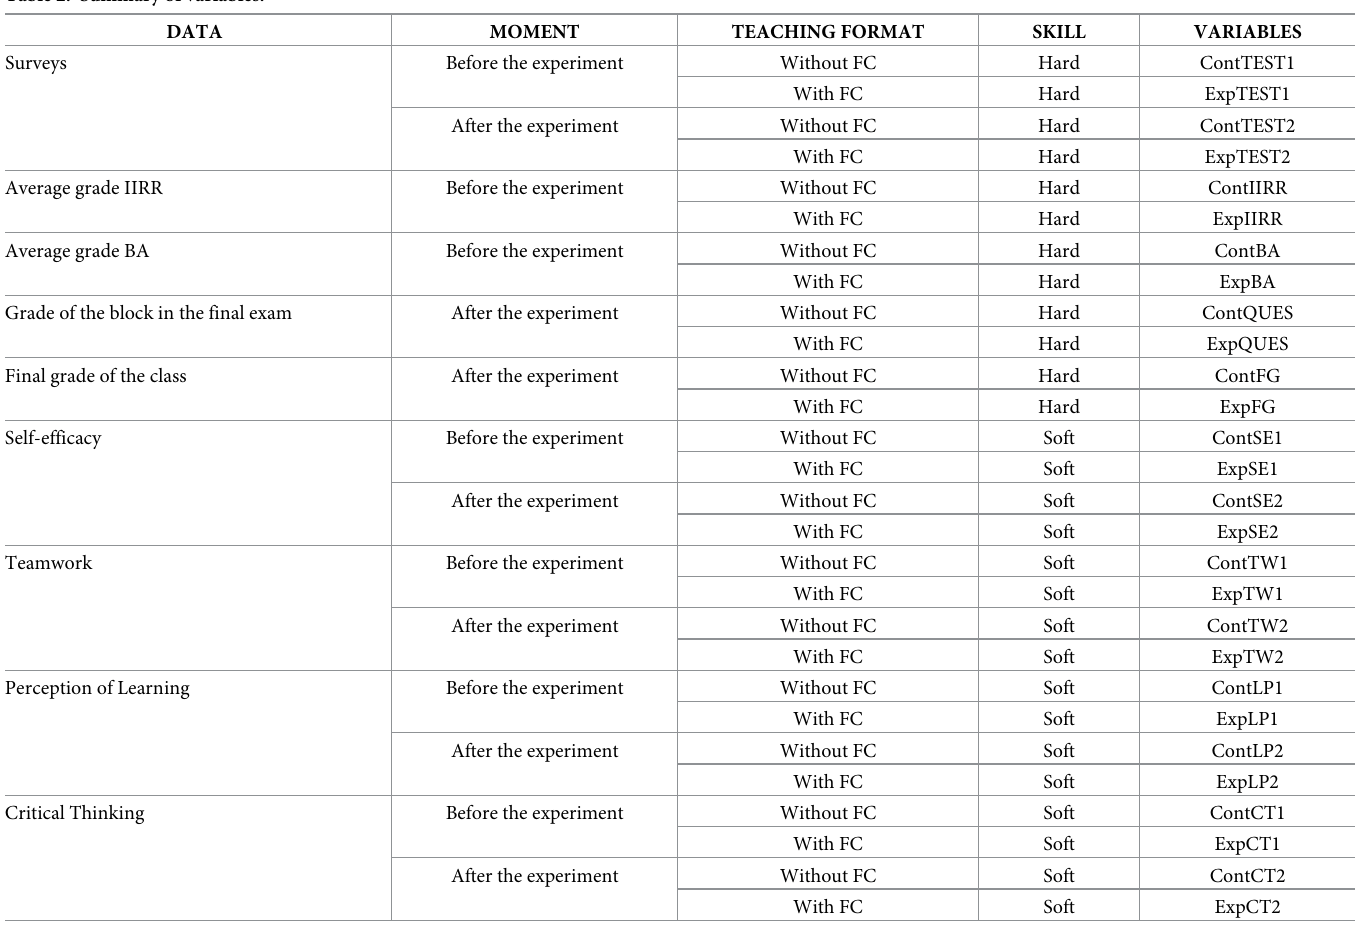
Table 2. Summary of